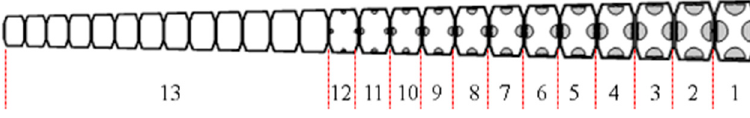
Figure 10. Pentamode material acoustic stealth cloak material laying unit. Table 1. Parameter distribution of pentamode materials in each layer.